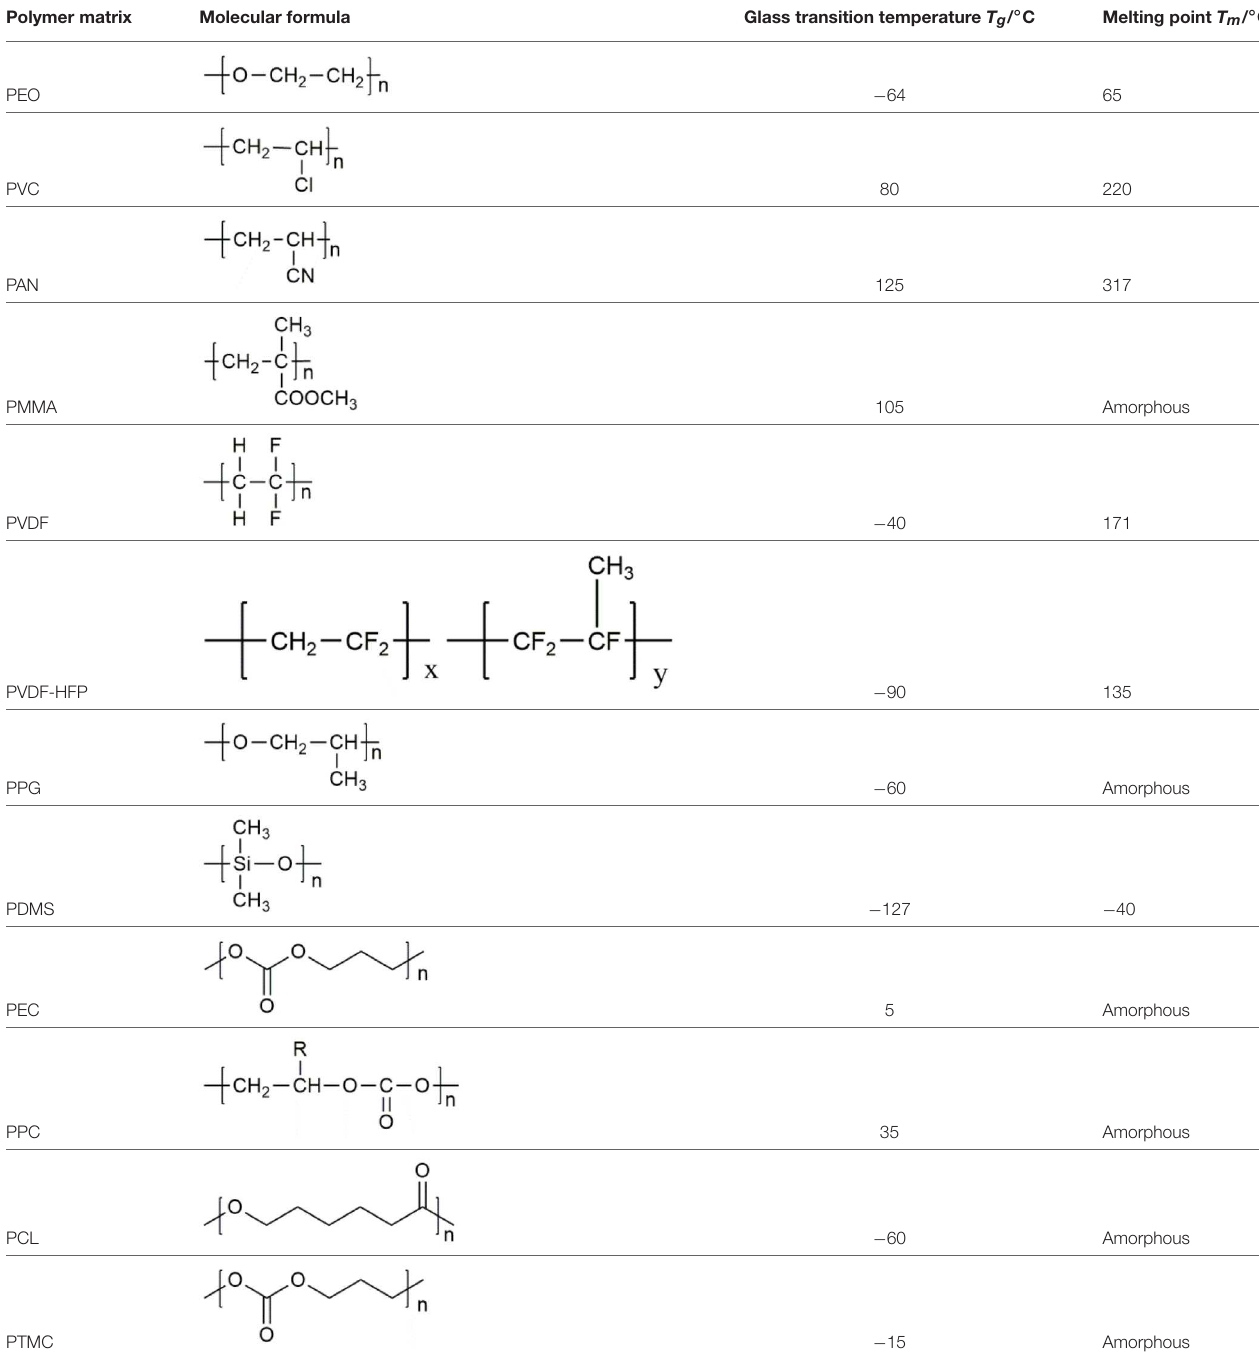
TABLE 1 | Common polymer matrix. Polymer